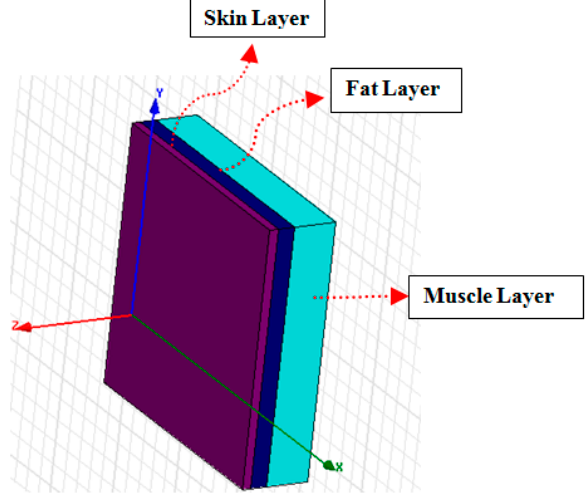
Figure 14. Customized 3-D human body model layer.